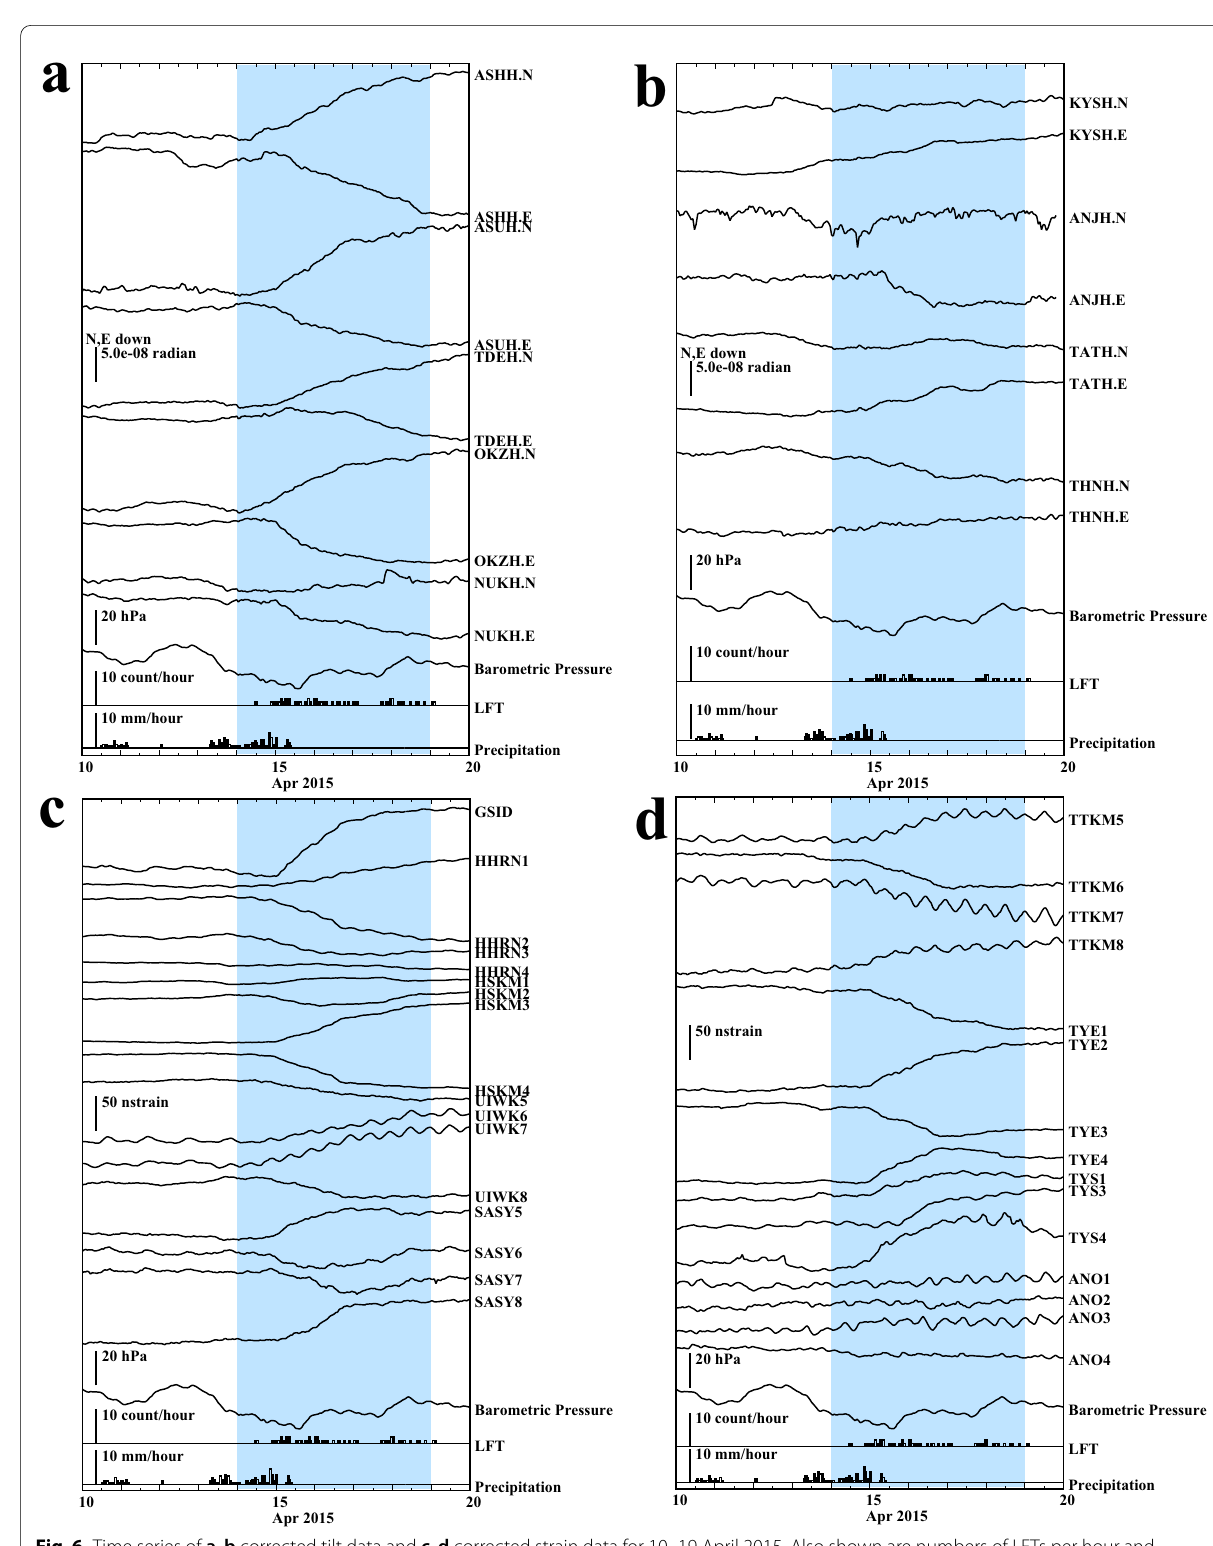
Fig. 6 Time series of a , b corrected tilt data and c , d corrected strain data for 10–19 April 2015. Also shown are numbers of LFTs per hour and barometric pressure and precipitation data from Hamamatsu weather station. Linear trends have been removed from the original strain and tilt data. Data from the period in blue (0000 on 14 April to 0000 on 19 April) were used to estimate slip distribution in this